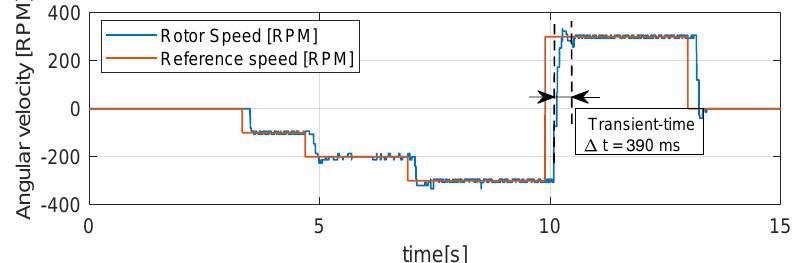
Figure 11. Rotor speed (experimental test